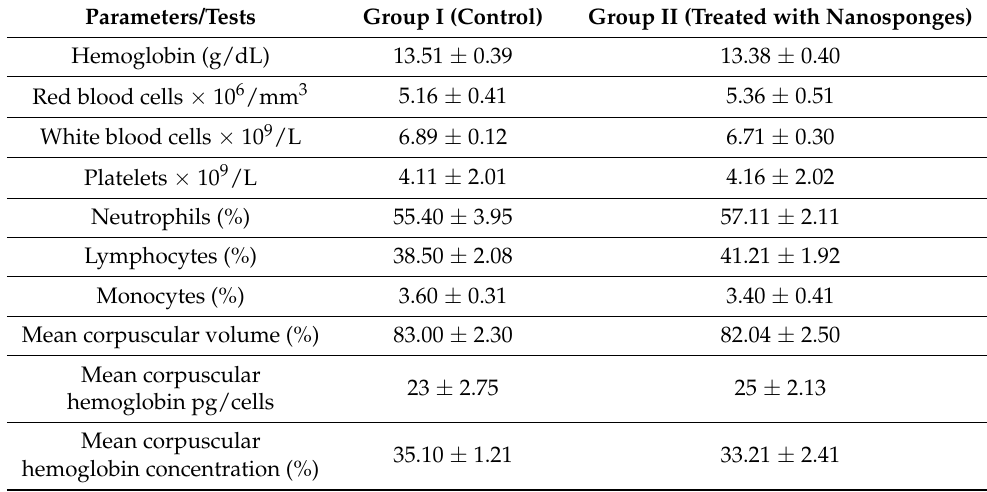
Table 4. Blood analysis of test animals in control group I and test group II.